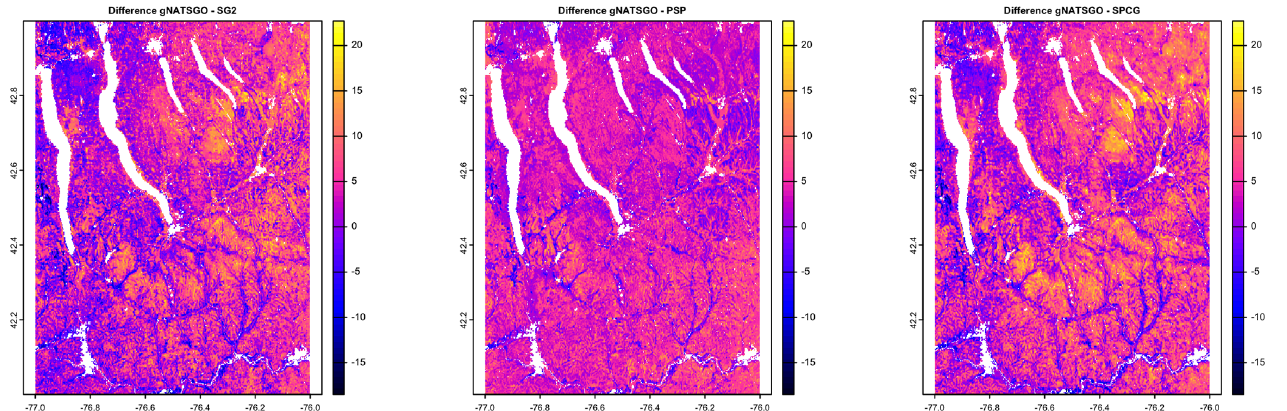
Figure 8. Difference between gNATSGO and DSM products for pH × 10 at 0–5cm. See the text for a discussion.